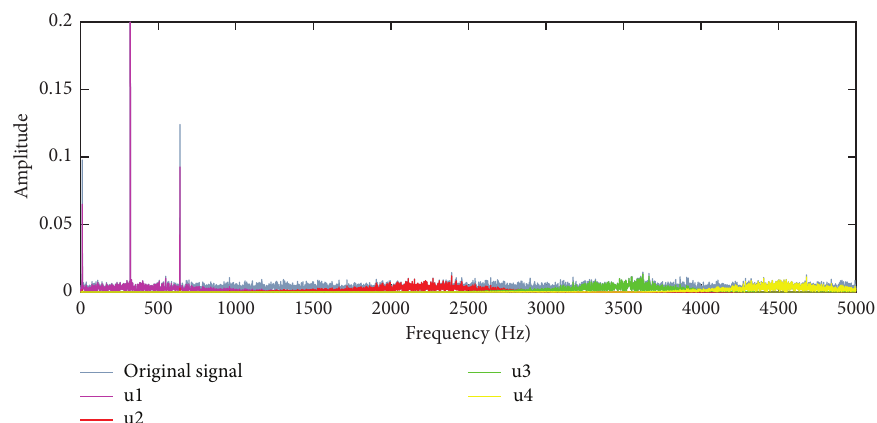
Figure 14: Simulated signals of case 2: the spectrum of each component based on IPAVMD.